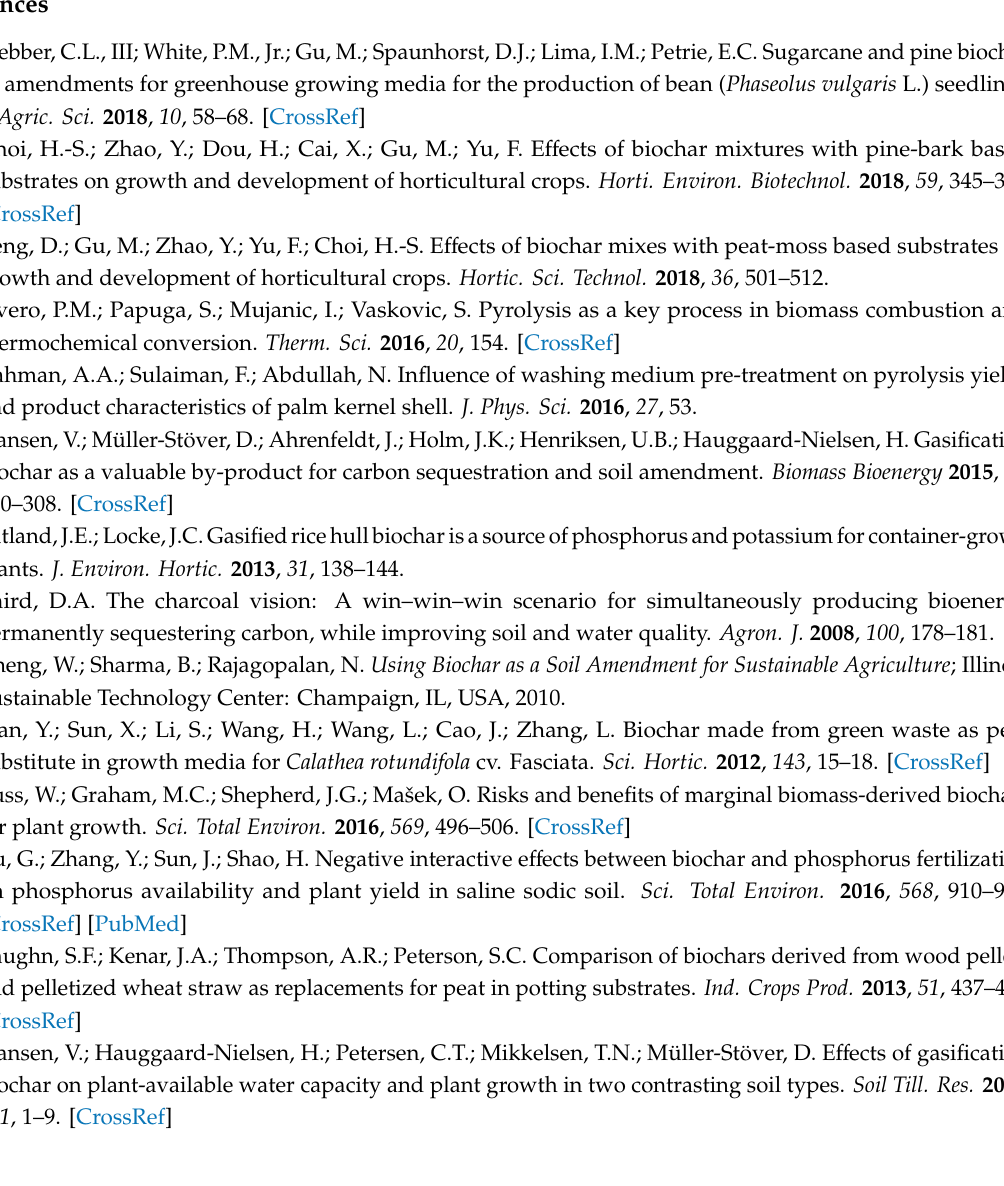
Table S1: The leachate pH of the 17 substrates with basil and tomato plants at 0, 2, 4, 6, and 9 weeks after transplanting (WAT), Table S2: The SPAD reading of basil and tomato leaves in 17 substrates at 2, 4, 6, and 9 weeks after transplanting (WAT), Figure S1: Cumulative growth index (mean ± standard error) per basil (a) or tomato (b) plant grown in 17 substrates at 0, 2, 4, 6, and 9 weeks after transplanting (WAT), Figure S2: Shoot (a) and total (b) dry weight (mean ± standard error) per basil plant harvested at 9 weeks after transplanting, and Figure S3: Leaves (a), stem (b), root (c), combined flower and fruit (d), and total (e) dry weight (mean ± standard error) per tomato plant harvested at 9 weeks after